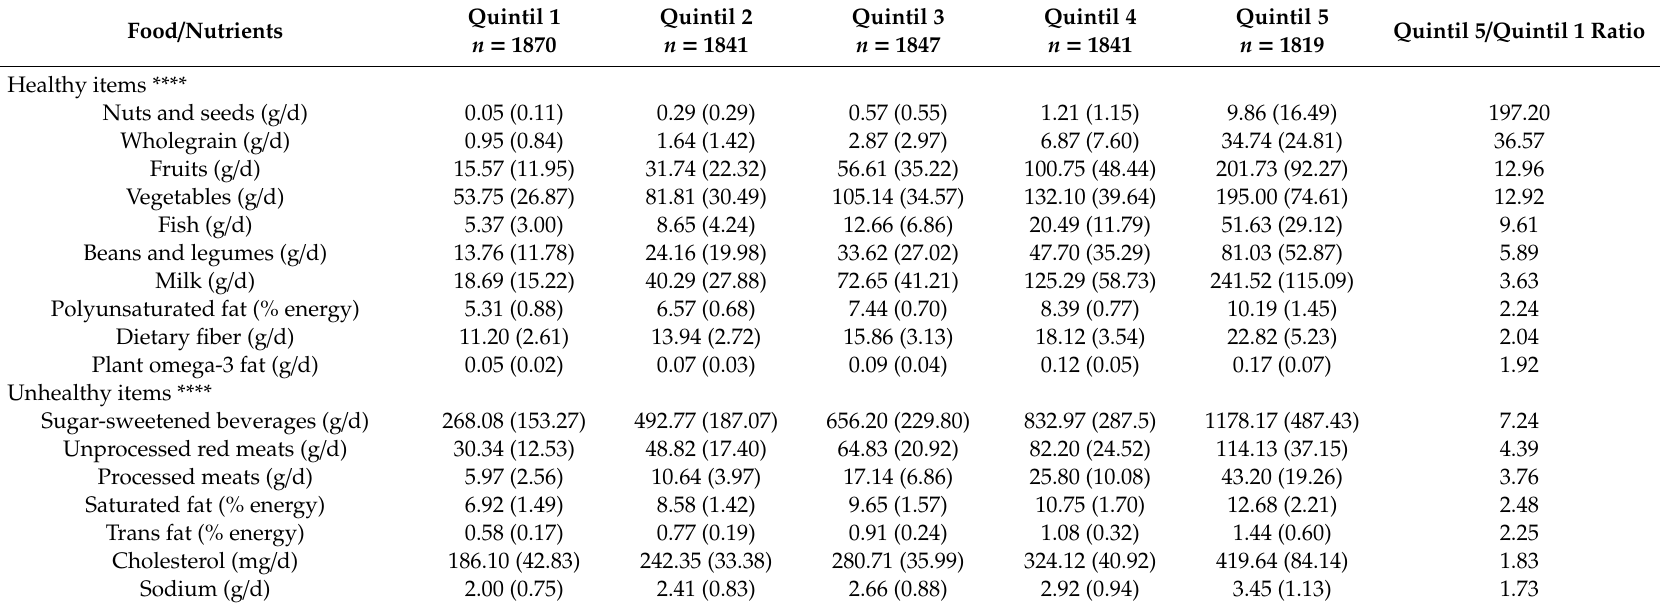
Table 1. Dietary consumption of selected foods groups and nutrients in individuals residing in urban areas of Latin American countries ( n = 9218) according to